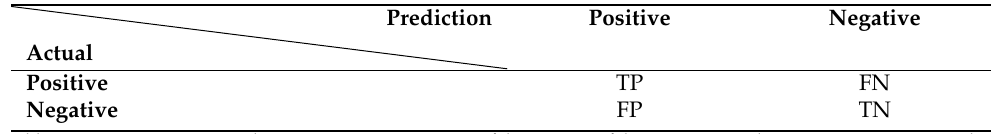
Table 2. The definitions of TP, FP, FN, and